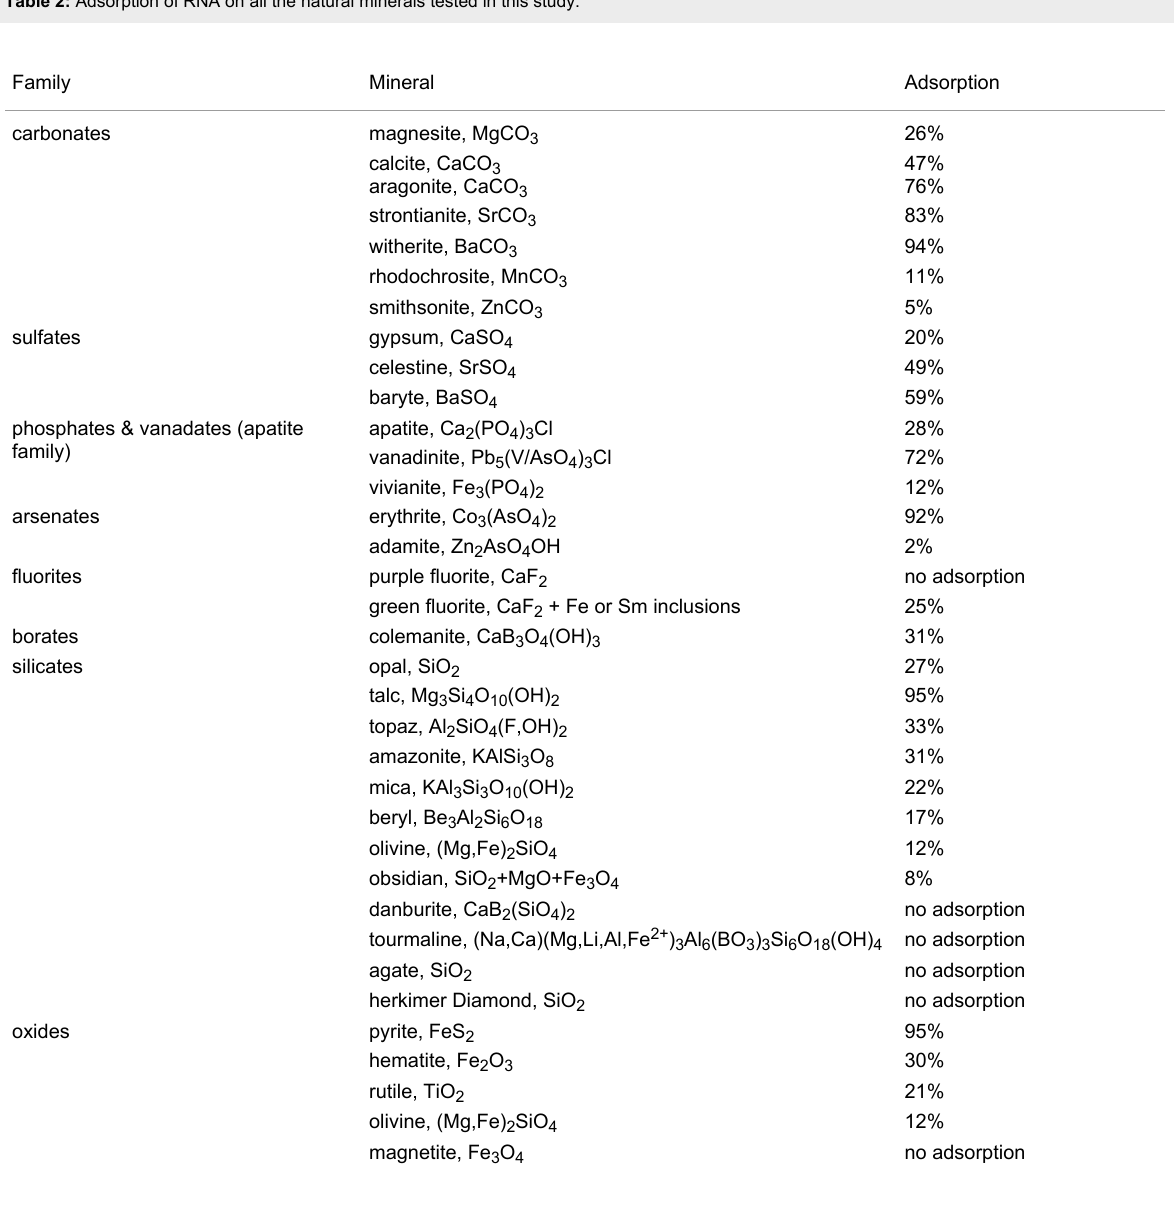
Table 2: Adsorption of RNA on all the natural minerals tested in this